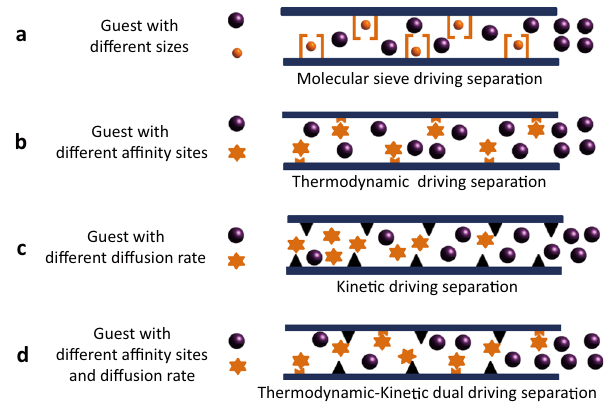
Fig. 2 Illustration of adsorption separation mechanisms in physisorbents. a Molecular sieving. b Thermodynamically driven separation. c Kinetically driven mechanism. d Thermodynamic-kinetic dual-driving mechanism.